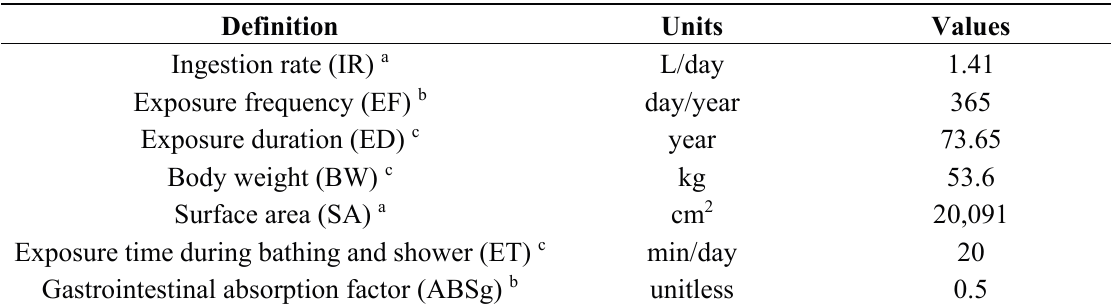
Table 1. The random variables in HQ